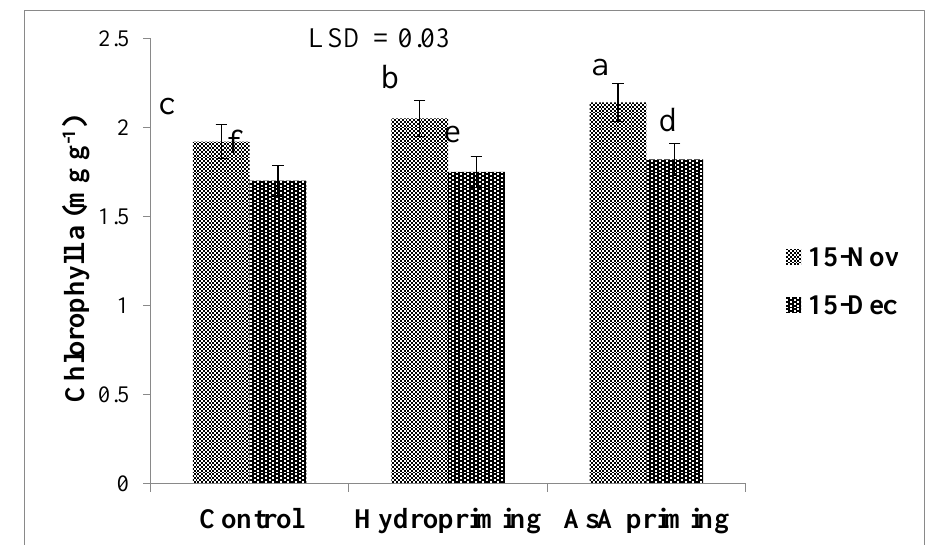
Figure 4. Interaction between priming techniques and sowing dates for chlorophyll a during 2017. Means not sharing same letter (s) differ significantly at p ≤ 0.05.